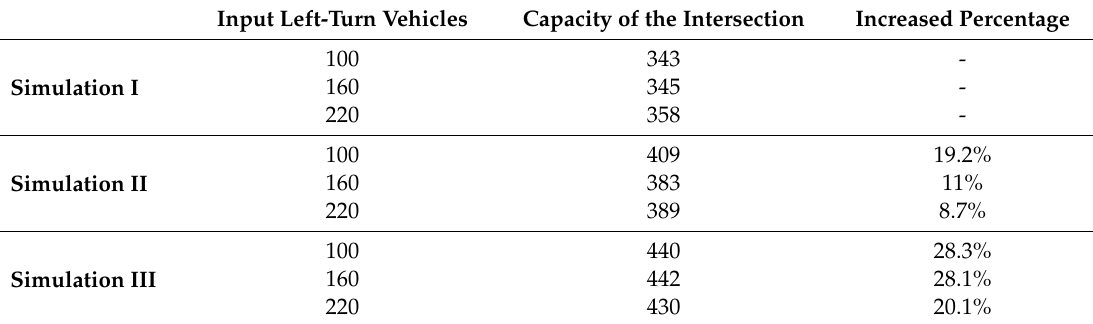
Table 1. The simulation results.